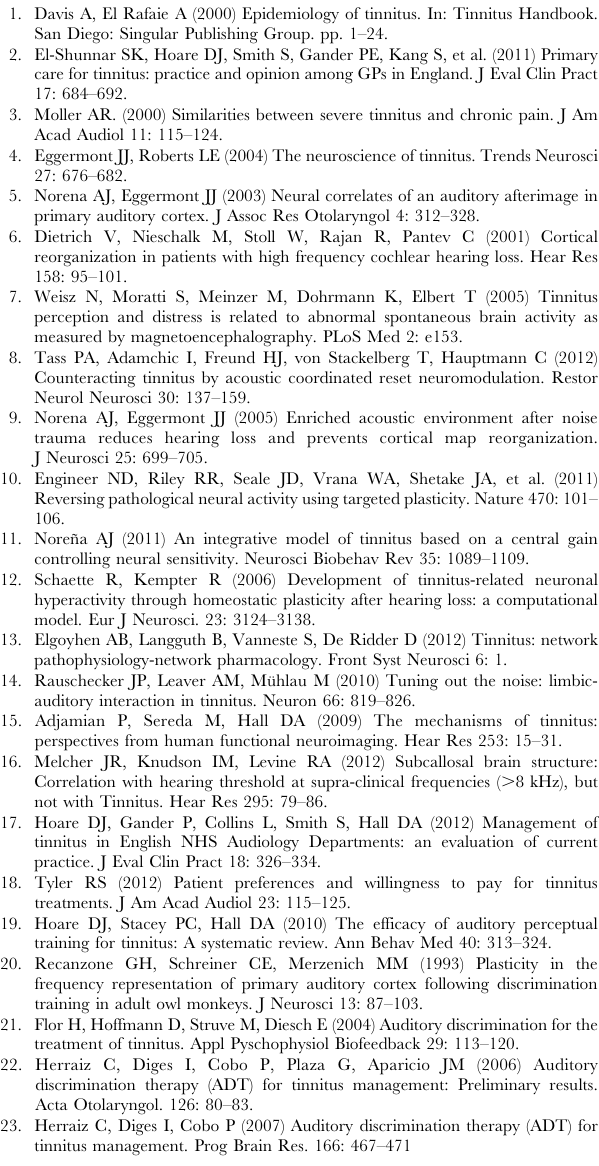
Table S1 Codes on product reaction